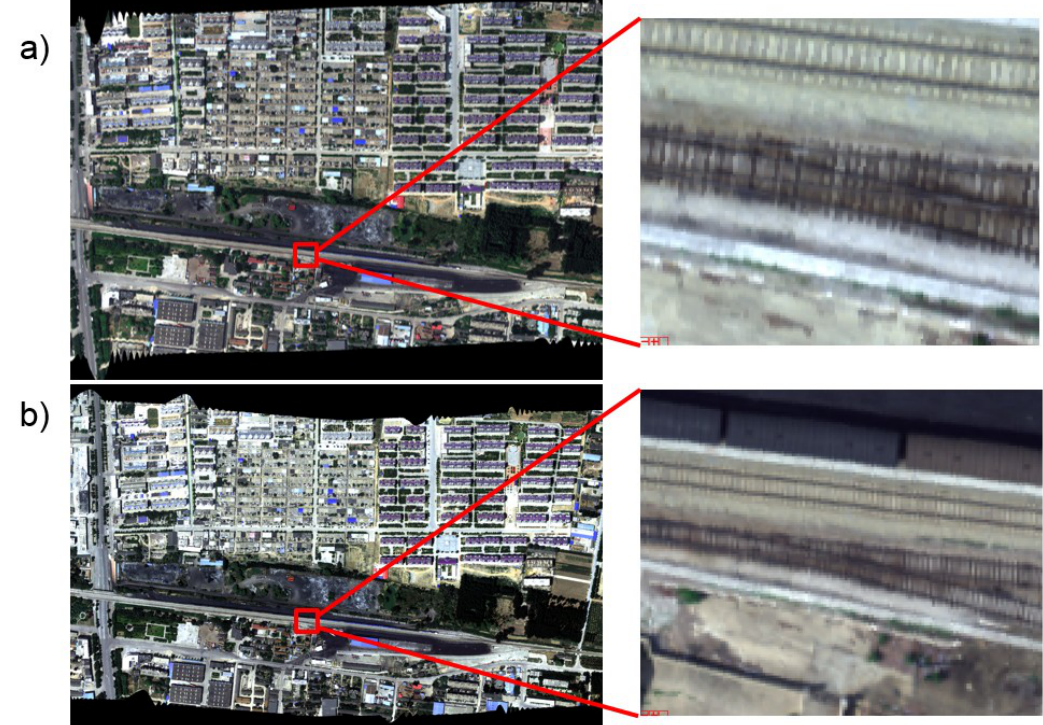
Figure 20. RGB synthesis image at high spatial/spectral resolution mode. ( a ) Is high spatial mode (instantaneous field of view (IFOV) = 0.125 mrad) and ( b ) is high spectral mode (IFOV = 0.25 mrad).